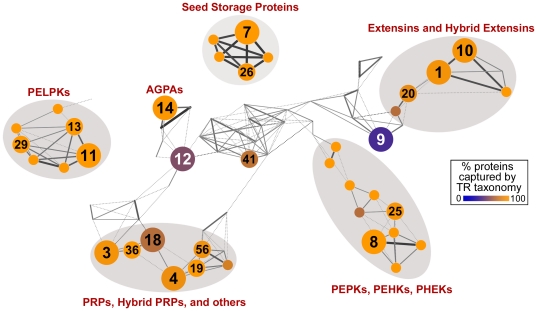
Cluster landscape of Pro-rich TR motifs from plant secretome sequences.Each node represents a TR cluster, node labels denote the original cluster identifier (see Tables S9, S10), and edge thickness represents the fraction of times each pair of TR clusters was co-clustered over ensemble re-sampling (see
Materials and Methods
) (also see “pairwise affinity” defined in Figure 4 of [49]). Thin, dotted, edges indicate a co-clustering of <10%. Large labeled nodes in the network denote clusters containing secreted TRPs found in at least ten species and twenty protein sequences (Table S10) while intermediate size labeled nodes satisfy one of these two criteria. Smaller unlabeled nodes do not meet either criterion, but are shown due to their similarity in motif content to larger, neighboring nodes. Major TRP classes from Tables S6, S7 and S8 are indicated around corresponding TR motif super-classes (circled in gray). Node color represents the retention rate of the TR taxonomy (Tables S3, S4, S5), defined as the proportion of all protein sequences corresponding to each cluster that are captured by TR class definitions (for class definitions, see Table S11; for a quantitative version of the taxonomy retention rate, see Table S10). For a high-resolution version of this network showing all individual TR consensus sequences, see Figure S1, and see Figure S2 for the same high-resolution network also showing TR super-classes. For details of network construction, see
Materials and Methods
. This network was rendered using Cytoscape 2.6.0 [50].